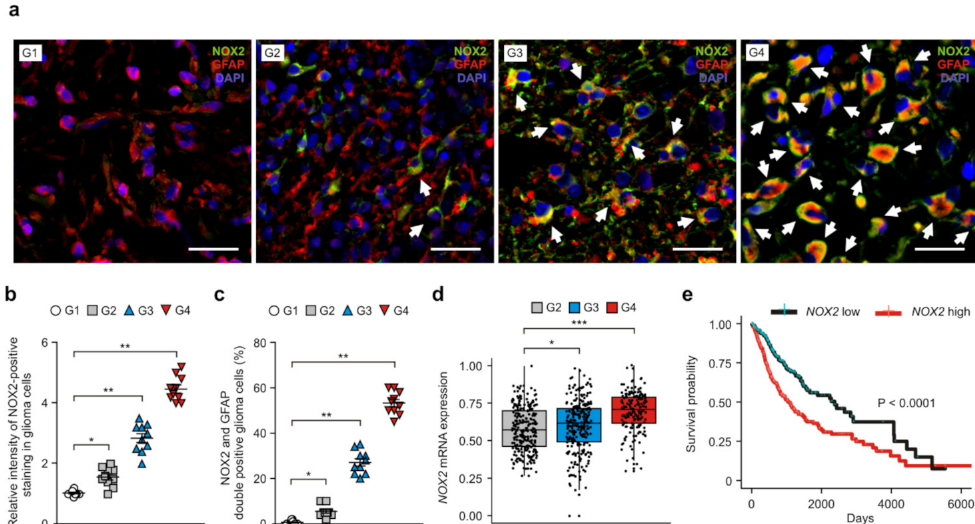
Figure 1. The levels of NOX2 are elevated in patients with GBM compared to low-grade glioma. ( a ) Representative immunofluorescence images of NOX2 staining in patients with GBM (G4), G3 glioma (G3), G2 glioma (G2), and G1 glioma (G1) showing NOX2 (green), GFAP (red, glioma cells), and DAPI-stained nuclei (blue) (n = 3 per group, n = 10 images per individual subject). Scale bars, 20 µ m. White arrows indicate NOX2 and GFAP-positive glioma cells. ( b , c ) Relative intensity of NOX2-positive staining ( b ) and quantification of NOX2 and GFAP-positive glioma cells ( c ) from ( a ). ( d ) The levels of NOX2 mRNA in patients with GBM and LGG dataset from TCGA. Wilcoxon test with two-sided and one-sided. ( e ) The survival curve of patients with low (black) (n = 347) and high levels (red) (n = 346) of NOX2 mRNA (n = 693) from GBM and LGG datasets from TCGA. The two groups were divided according to median value. p < 0.0001; Kaplan–Meier estimation test with two-sided and one-sided. The results are representative of three independent experiments and are shown as the mean ± SEM. *** p < 0.001, ** p < 0.01, * p < 0.05; ANOVA or Student’s two-tailed t -test.